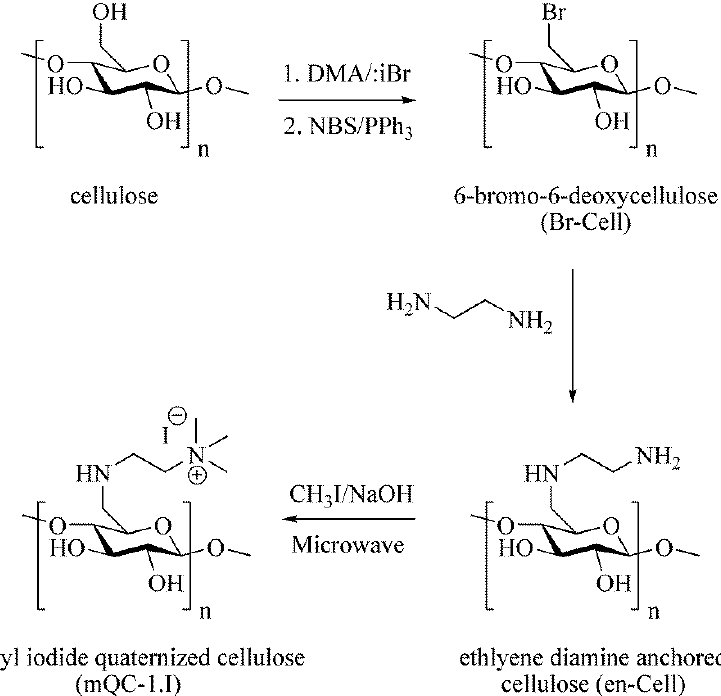
Scheme 8. Synthesis of quaternized cellulose (DMA = N , N -dimethylacetamide, LiBr = lithium bromide, NBS = N -bromosuccinimide, PPh 3 = Table 3. Summary of reaction conditions and yields for epoxides conversion to cyclic carbonates using functionalized biomass-based catalysts (propylene oxide (PO) and styrene oxide (SO)). Entr Catalyst Co-catalyst Reaction Conditions y 1